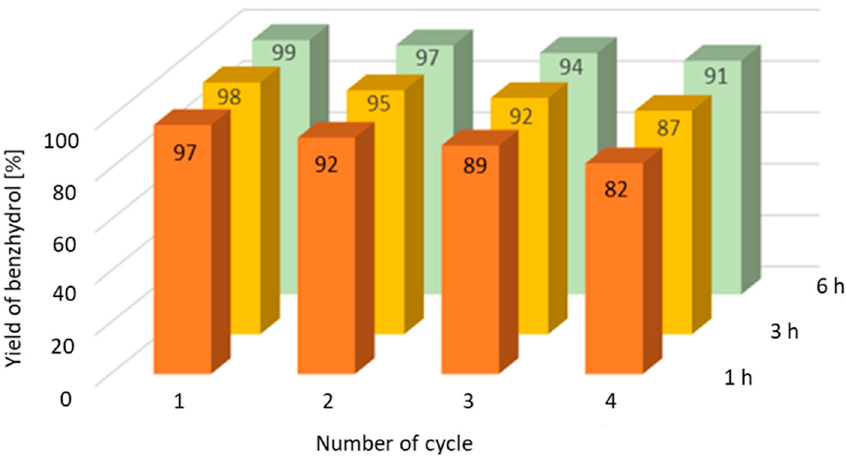
Figure 5. Recycling test of MgO in liquid phase transfer hydrogenation of Ph 2 CO with 2-octanol. Reaction conditions: W MgO = 250 ± 5 mg, 3.125 mmol of ketone, D/A = 8, selectivity >98%.